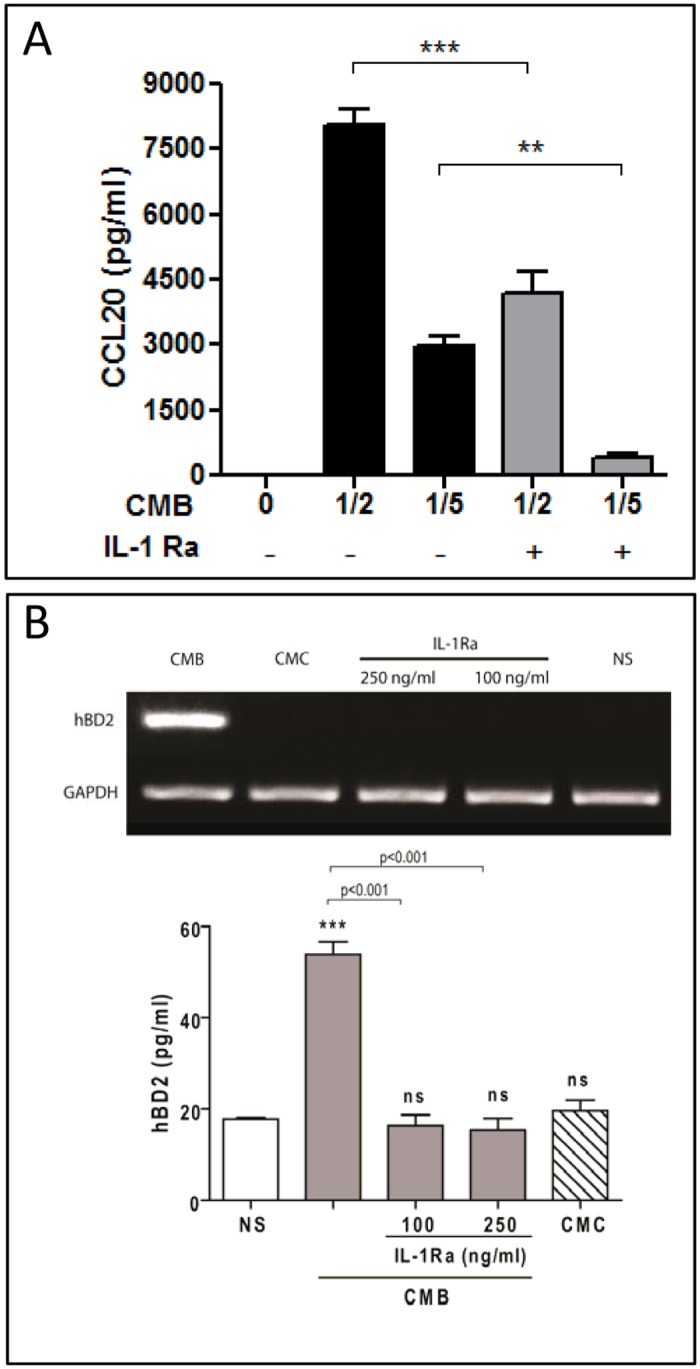
IL-1β mediates the stimulating effect of CMB on CCL20 and hBD2 secretion by alveolar epithelial cells.A549 cells were preincubated with IL-1Ra for 1 h at 37°C before stimulation with conditioned medium from B. abortus-infected THP-1 monocytes (CMB) or from uninfected monocytes (CMC) (at 1/2 and 1/5 dilution in A, at 1/5 dilution in B). At 24 h post-stimulation CCL20 levels (A) and hBD2 levels (B) were measured in culture supernatants, and the expression of mRNA for hBD2 was determined in cells. ELISA data are mean ± SEM of CCL20 or hBD2 levels measured in three independent experiments. **, p<0.01, ***, p<0.001, and ns, non-significant difference versus non-stimulated (NS) cells (ANOVA followed by Dunnett’s test).